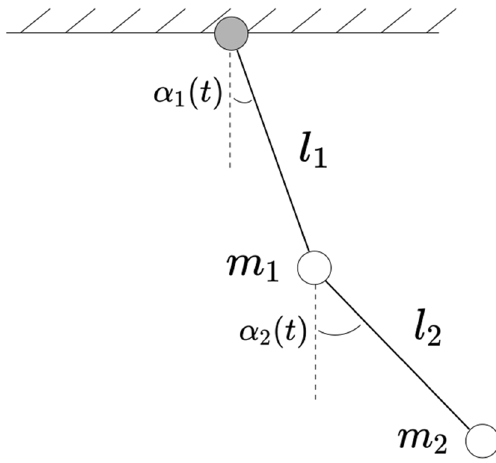
Figure 15. Double pendulum system.